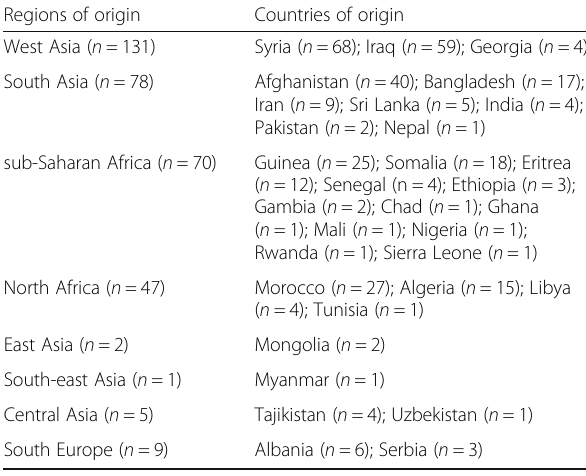
Table 1 Countries of origin of the UASA Regions of